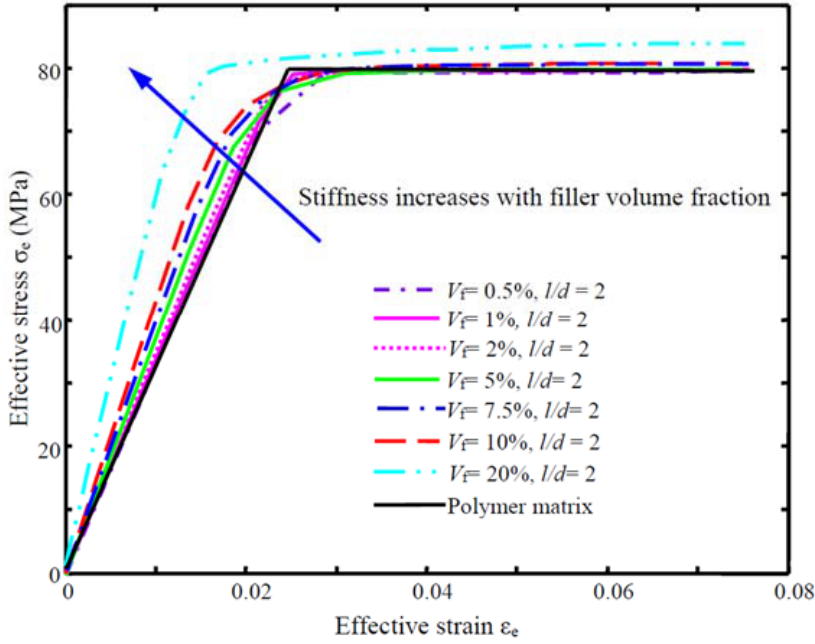
Figure 7. Effective stress-strain diagram σ e - ε e of the PNCs with the clay-particle aspect ratio ρ = 2 (plane-strain, case I).